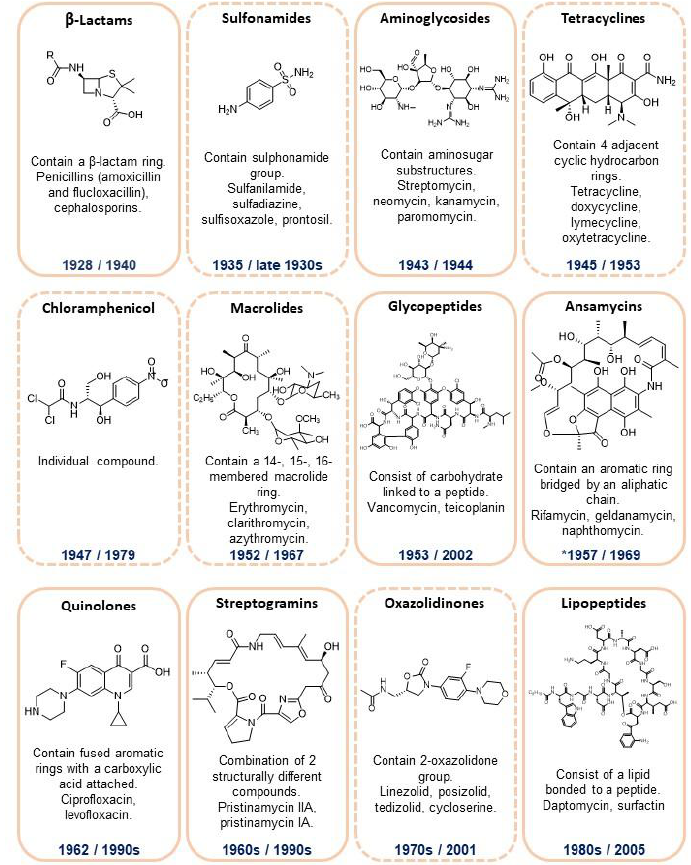
Figure 2. Illustration of different classes of antibiotics. Antibiotics that act as bactericidal agents, i.e., cause cell death, are shown in rectangles with orange borders; antibiotics that act as bacteriostatic agents, i.e., restrict growth and reproduction, are shown in rectangles with dashed line orange borders. Years shown in blue indicate when the antibiotic class was discovered (the first number), and when resistance was first reported (the second number). The structure and years of discovery and resistance refer to the first antibiotic from each class [35,40–46].